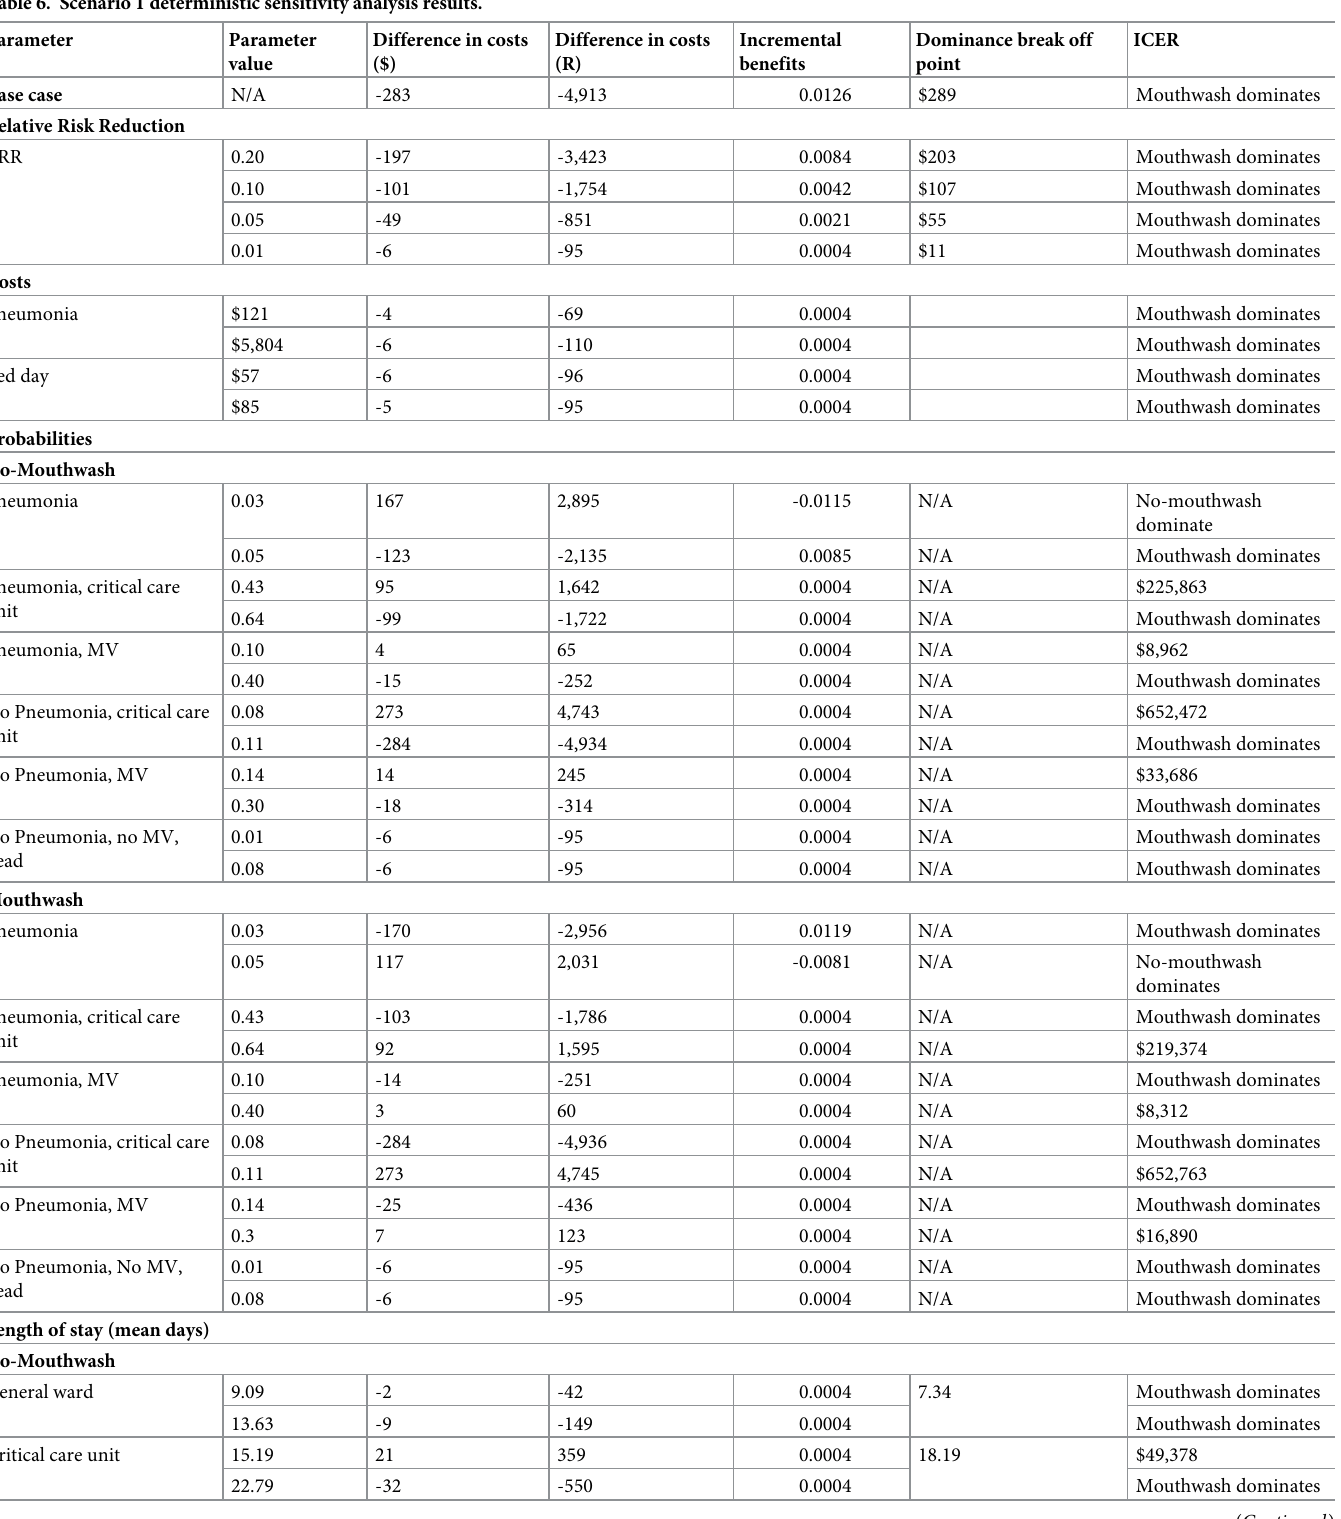
Table 6. Scenario 1 deterministic sensitivity analysis